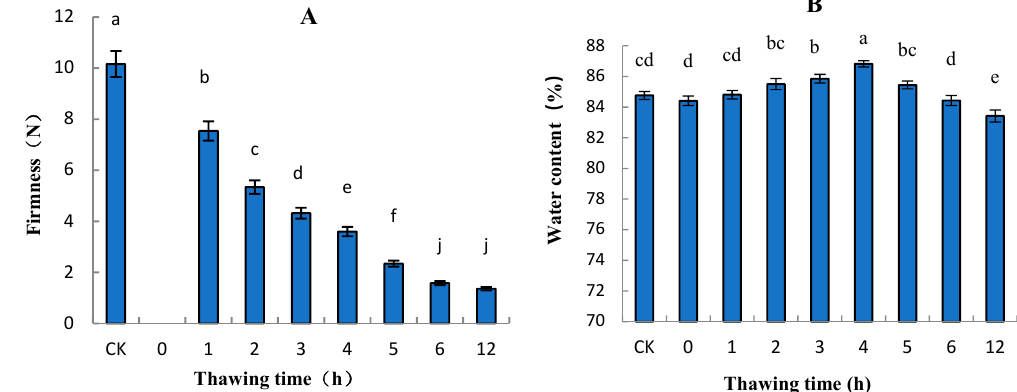
Figure 4. Changes in firmness ( A ) and water content ( B ) in “Ruaner” pear during the freezing–thawing stage. At 0 h, the fruit is frozen solid, so its firmness cannot be determined. Different letters indicated significant differences between thawing time treated and control (Duncan’s multiple range test, p < 0.05).